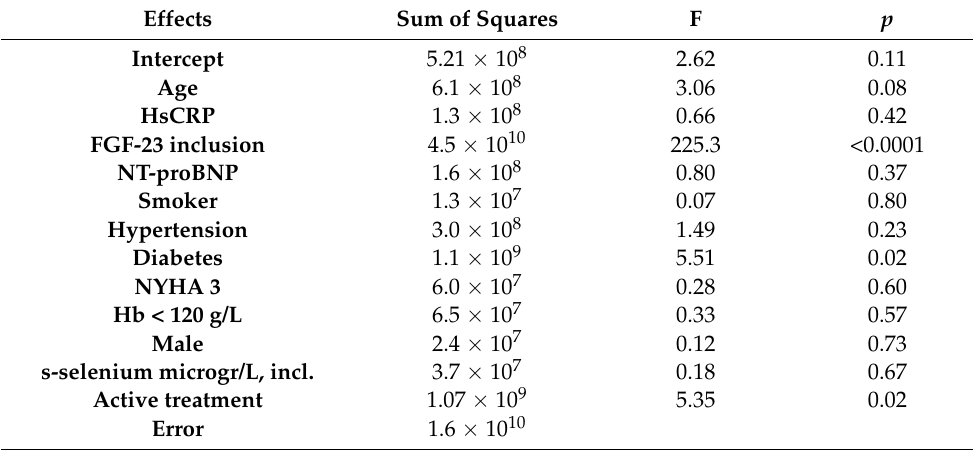
Table 2. Analysis of covariance using FGF-23 after 48 months as a dependent